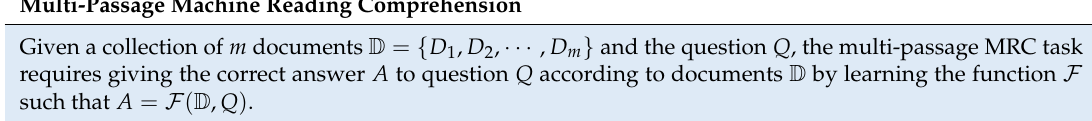
Table 13. Definition of multi-passage machine reading